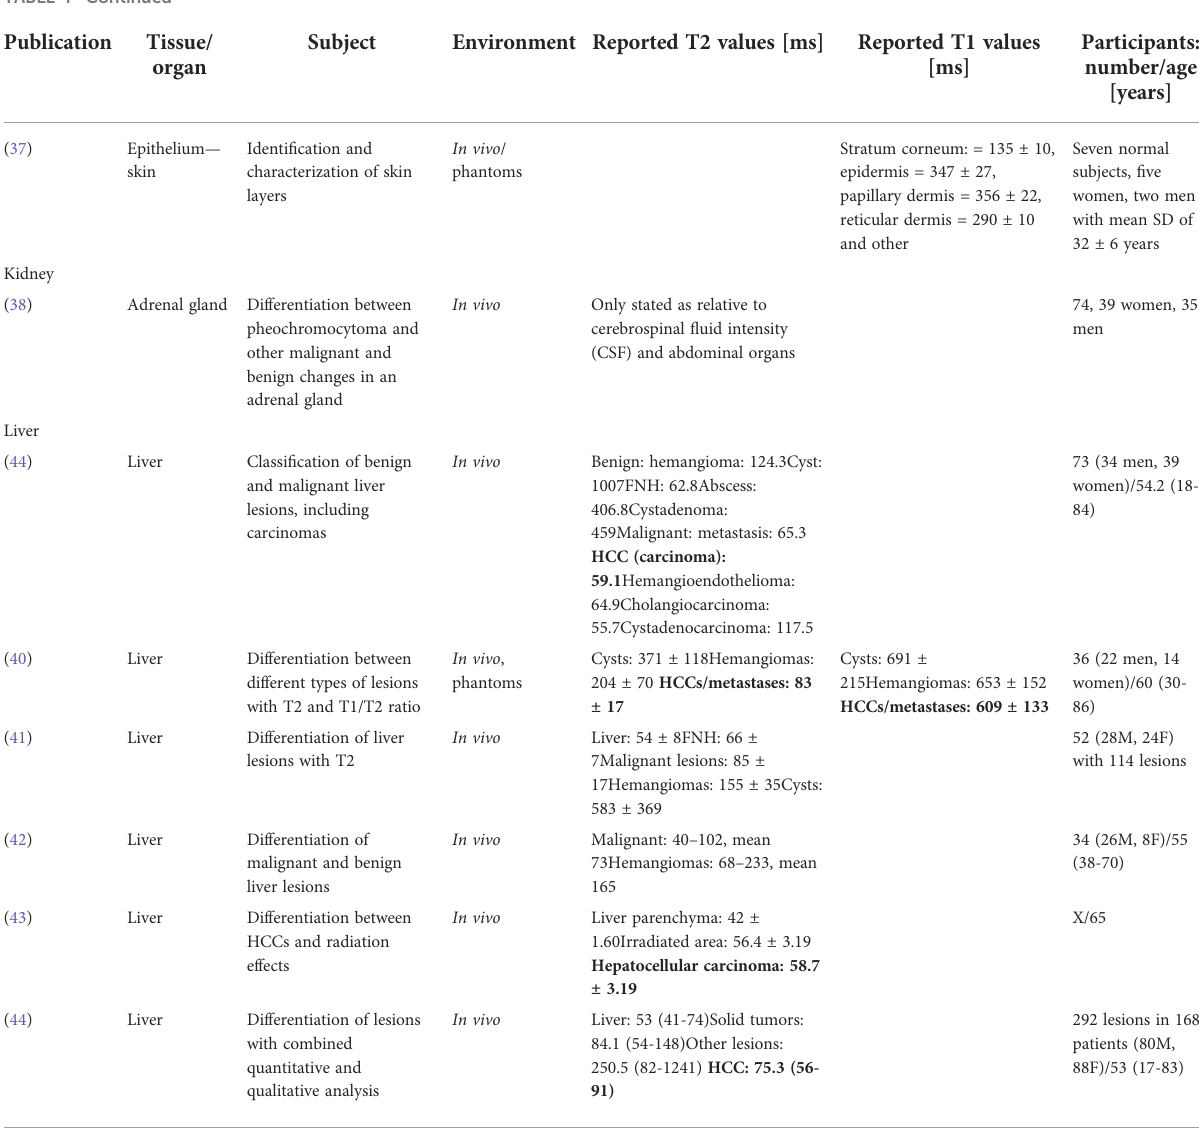
TABLE 5 Relaxation times reported for epithelial tissue.